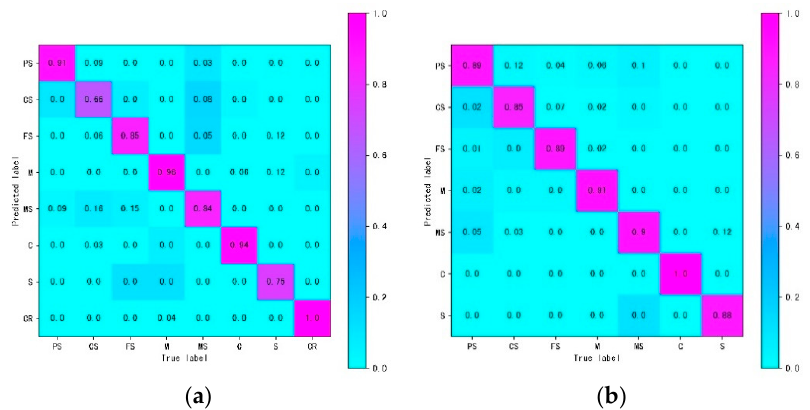
Figure 5. Heat map of Confusion matrix on the test dataset. ( a ) The DGF test dataset; ( b ) the HGF test dataset.